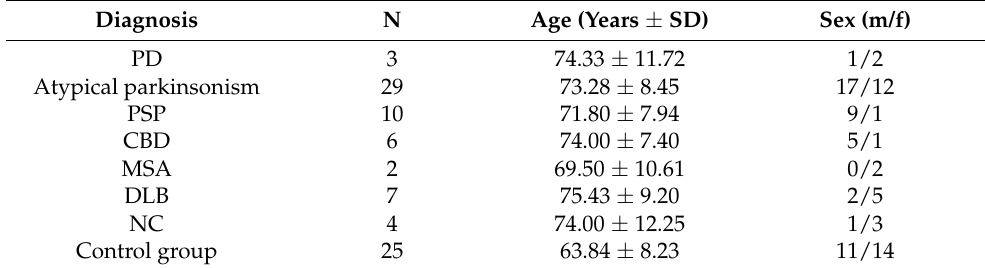
Table 1. Patient demographics of final study